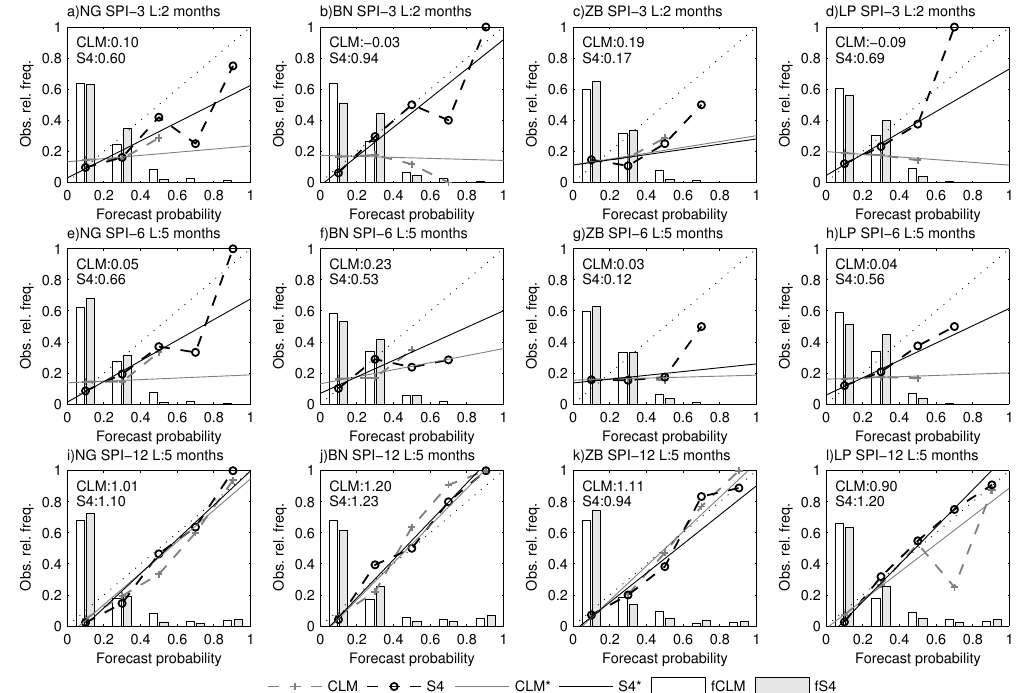
Fig. 9. Reliability diagrams (CLM, S4) and frequency histograms (fCLM, fS4) for SPI < − 1 forecasts produced by S4 (black lines and white bars) and CLM (grey lines and bars). For perfect reliability the curves should fall on top of the dotted diagonal line. The thin solid lines (CLM ∗ and S4 ∗ ) are the weighted least-squares regression lines of the reliability curves, and the slope of each curve is displayed in each panel. Each panel represents a particular basin (column) and SPI timescale (rows), with the same organization as in Fig. 8.